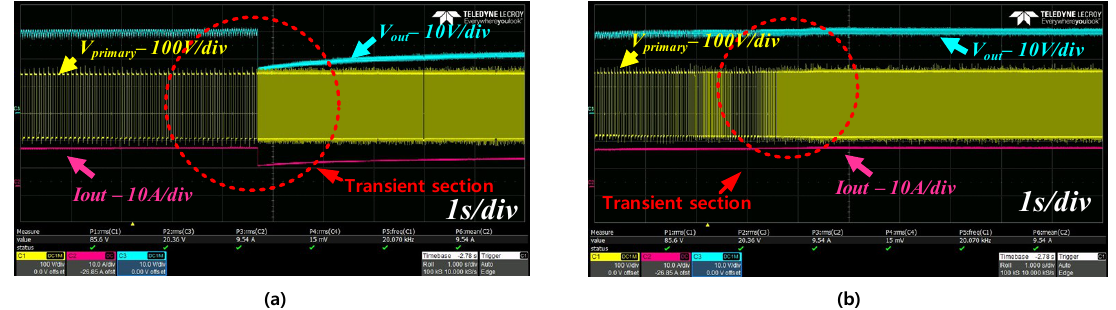
Figure 15. ( a ) The CC-CV mode charging waveform without the compensator; ( b ) the improved CC-CV mode charging waveform.